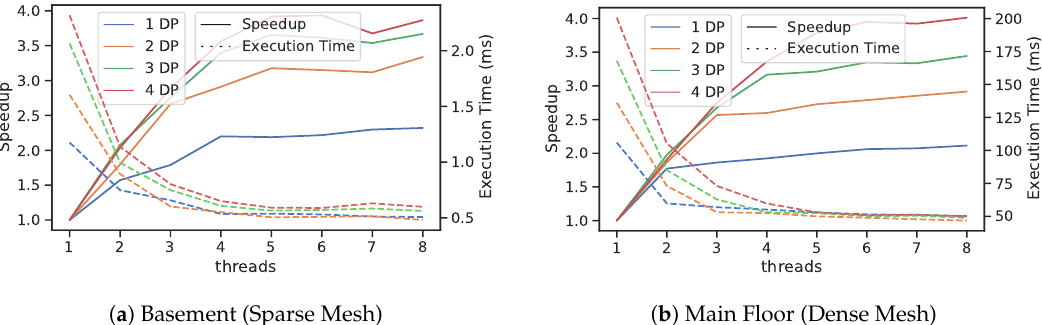
Figure 21. Results of parallel speedup and execution timing of plane/polygon extraction with up to eight threads. Both basement ( a ) and main floor meshes ( b ) are analyzed. Solid lines indicate parallel speedup and link to the left y -axis while the dashed lines indicate execution time and link to the right y -axis. The color indicates number of dominant plane (DP) normals